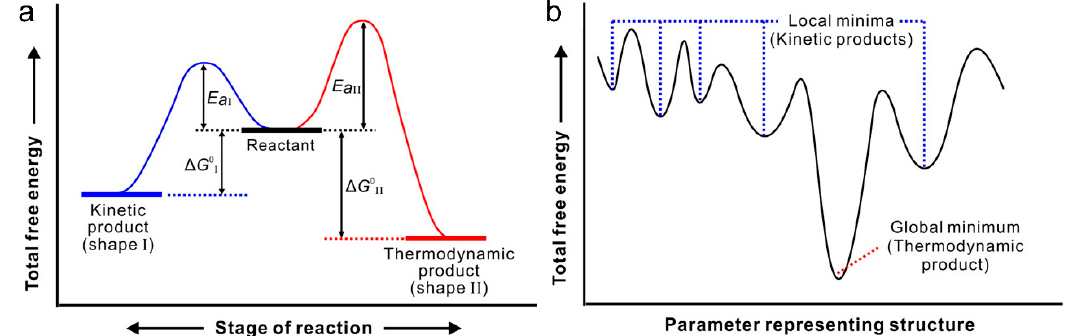
Figure 5. Schematic illustrations of thermodynamic and kinetic control for ( a ) two reactions, and ( b ) a series of reactions that involve product formation. Reproduced with permission from ref. [51].